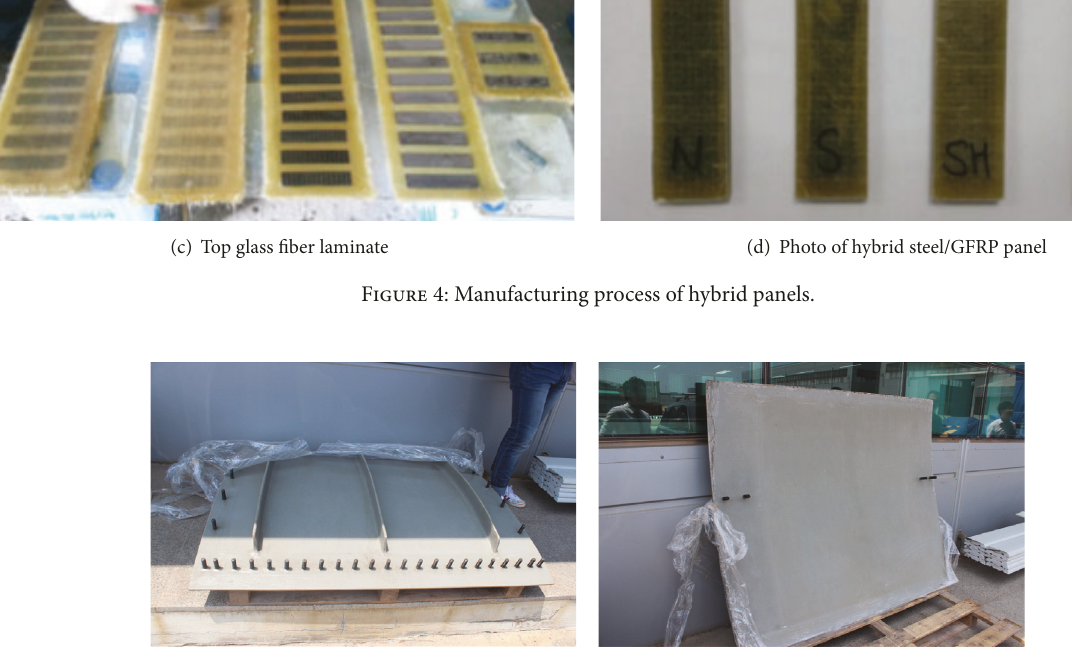
Figure 5: Photo of hybrid